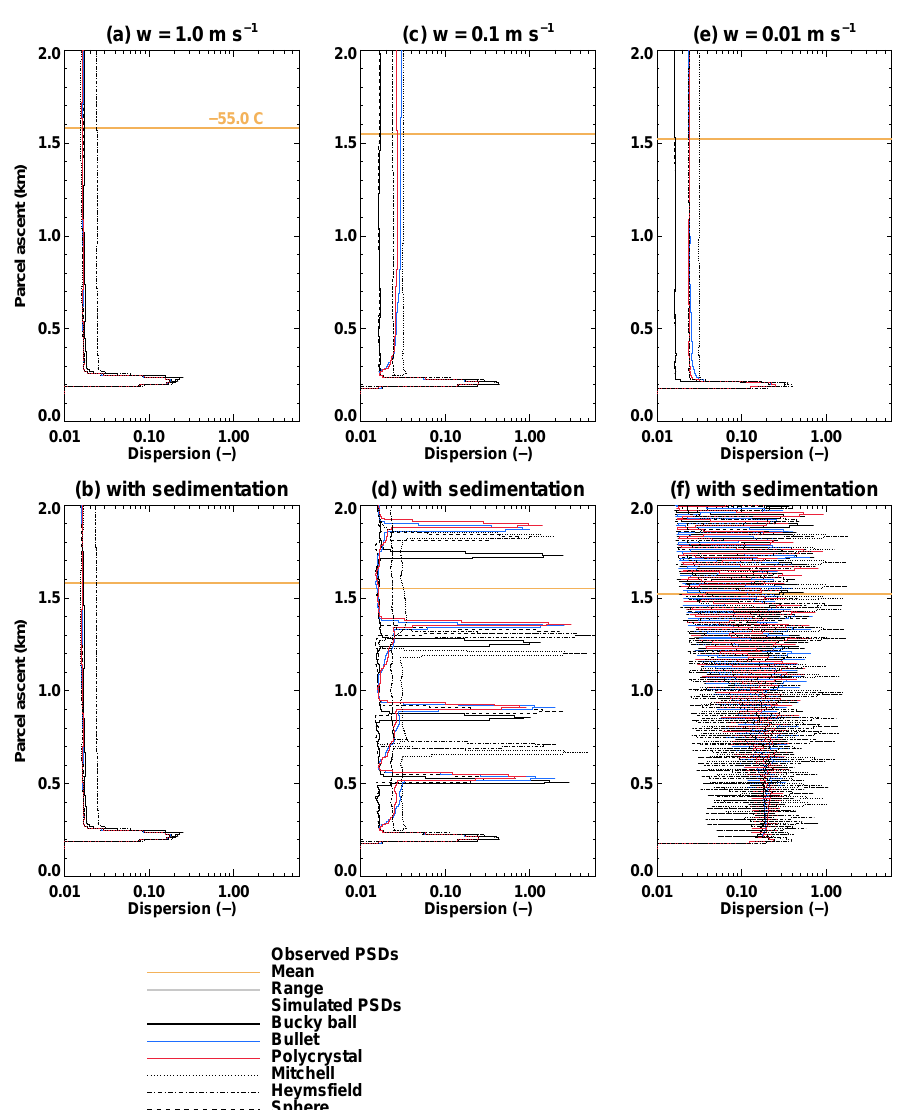
Figure 21. As in Fig. 18 except relative dispersion of the ice crystal size distribution.